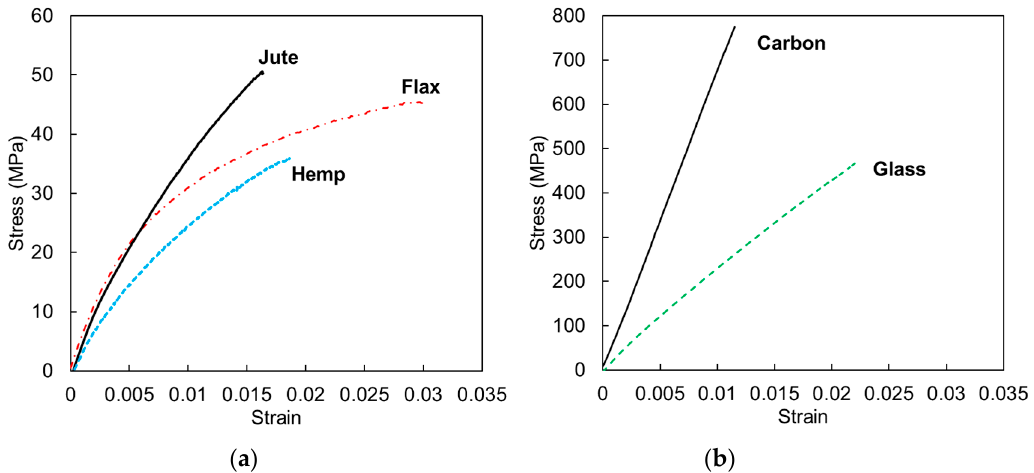
Figure 2. Exemplar uni-axial tension coupon material tests of the fiber composite laminates: ( a ) natural fiber composite laminates [17] and ( b ) synthetic fiber composite laminates.